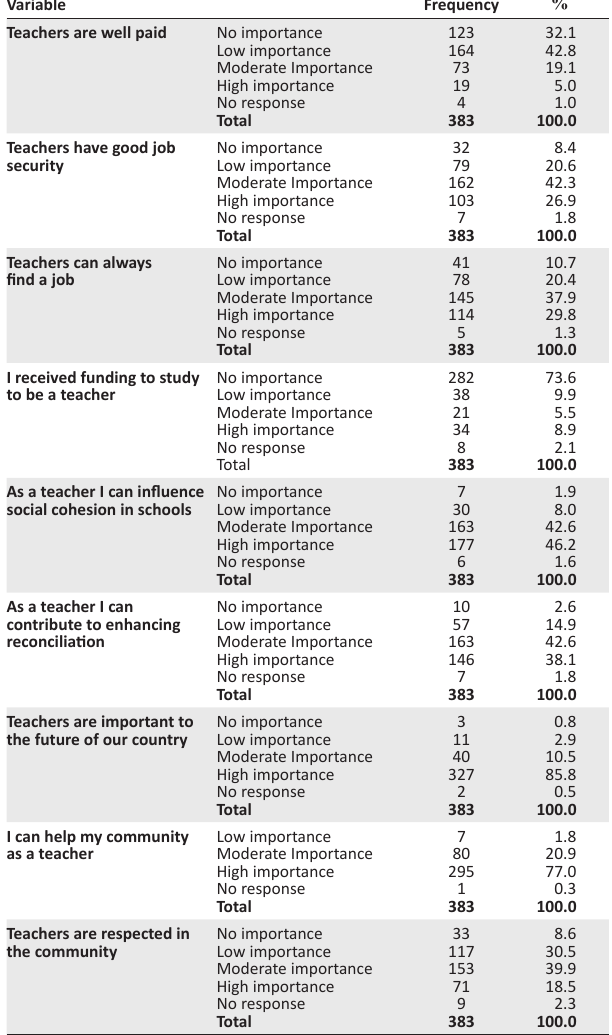
TABLE 2: Reasons for becoming a